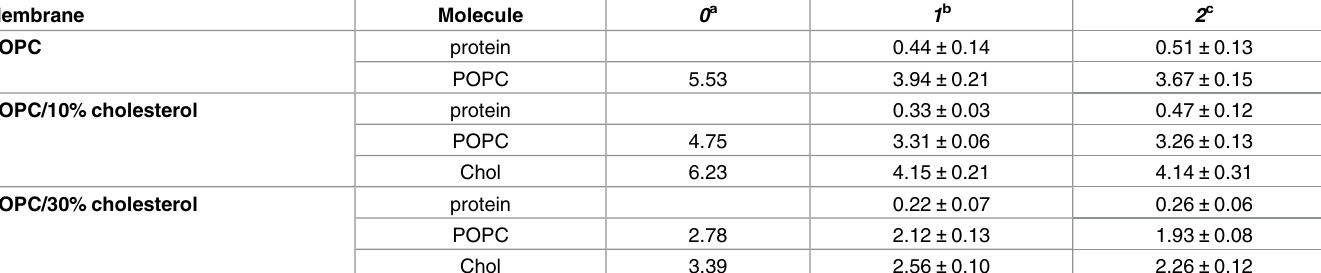
teins. In order to detect cholesterol binding residues, the average time for which any cholesterol Table 4. Diffusion